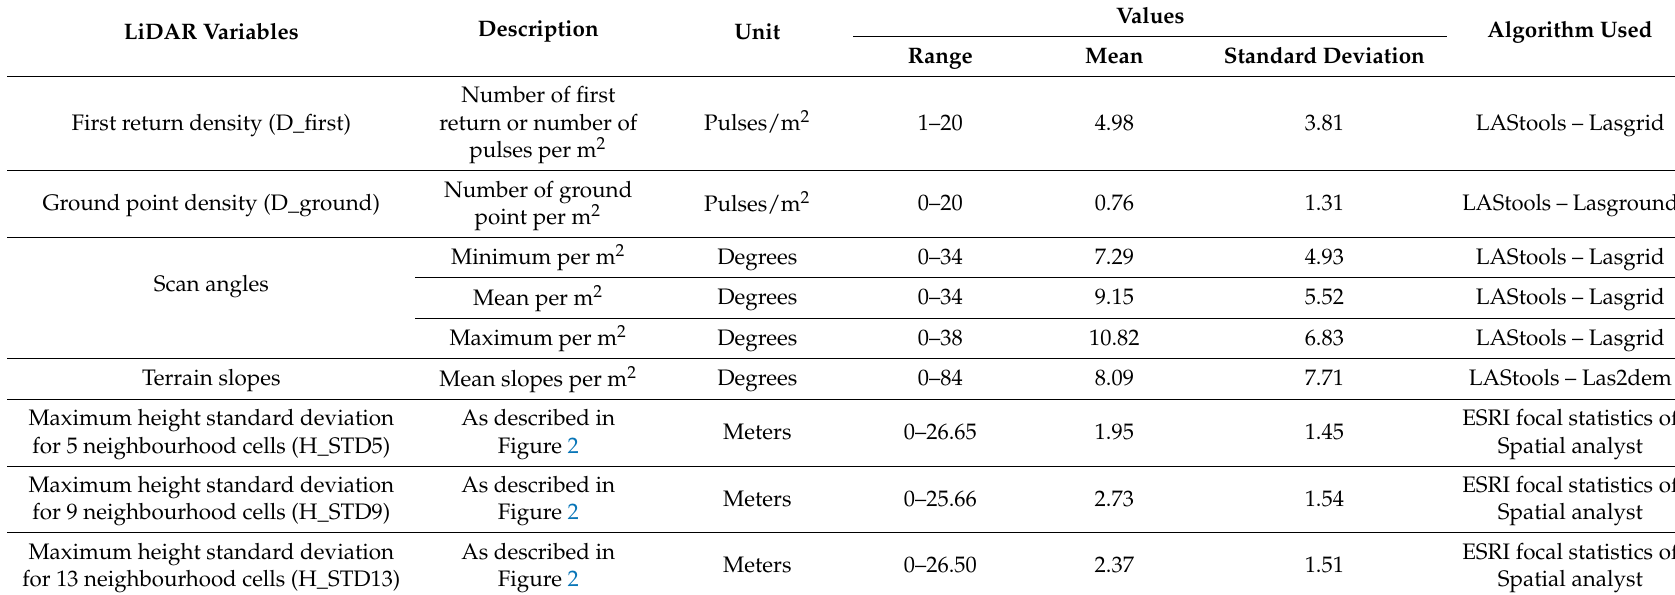
Table 3. LiDAR acquisition variables